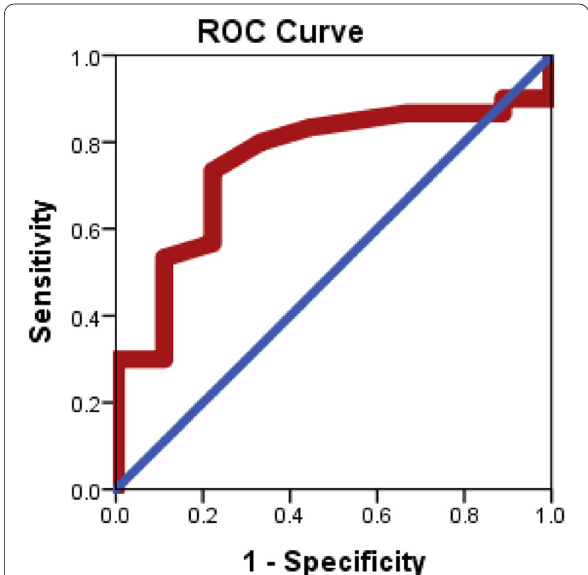
Fig. 5 ROC curve of complement C3 to distinguish between patients with NAFLD fibrosis score less than 1.455 from patients with NAFLD − fibrosis score > 1.455 −